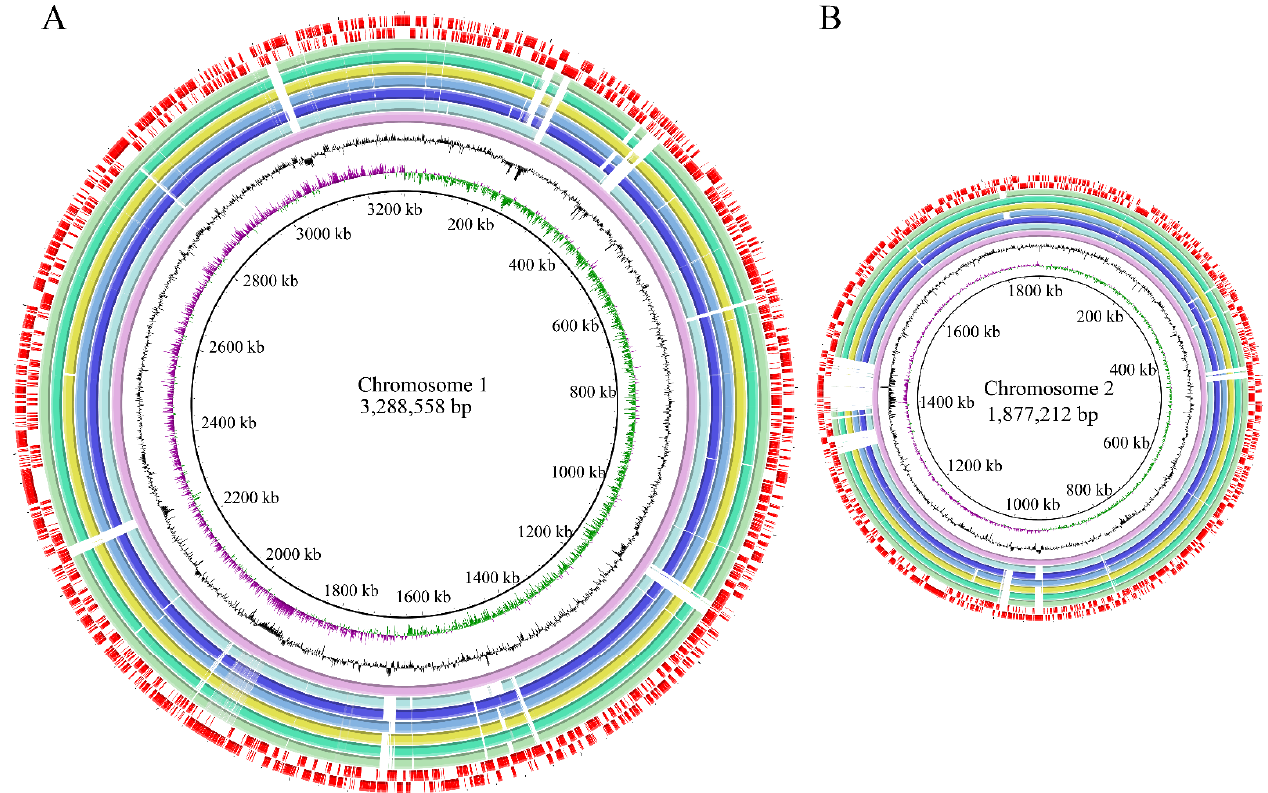
Figure 3. Genome circle maps of the six V. parahaemolyticus isolates. ( A , B ): represents the larger and smaller chromosomes of the six V. parahaemolyticus isolates, respectively. Circles from the inwards to outside: the first circle represents GC-skew (purple value is greater than zero, green value is less than zero); the second circle (in black), GC contents (outward part means higher than average, inward part means lower than average); the third circle (in light purple), the reference genome of V. parahaemolyticus RIMD 2210633; the fourth to nineth circles (in light blue to light green), V. parahaemolyticus L7-7, N1-22, N3-33, N4-46, N8-42, and Q8-15 genomes, respectively; and the tenth circle (in red), CDSs on the positive and negative chains (inward and outward parts), respectively.